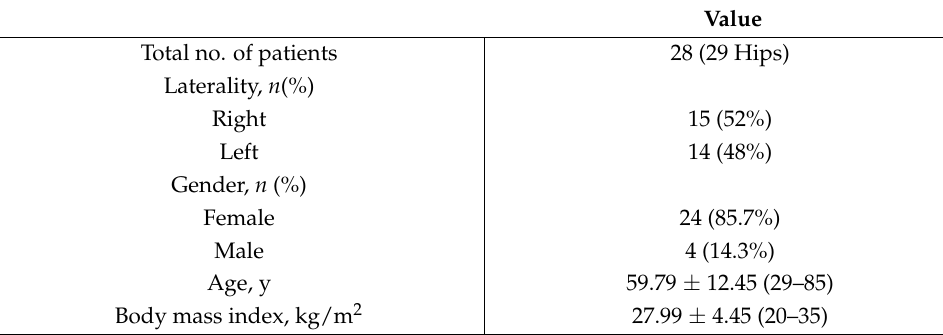
Body mass index, kg/m 2 27.99 ± 4.45 (20–35) Values are shown as n (%) or mean ± SD